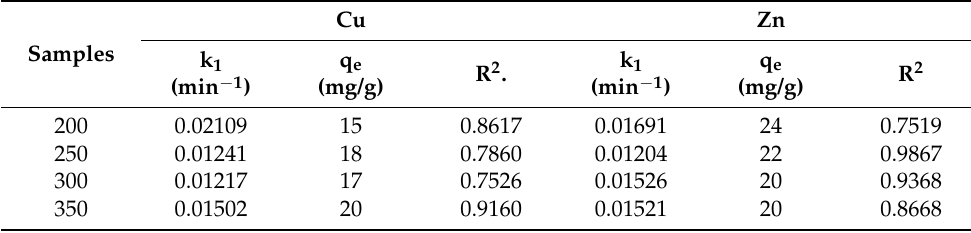
Table 2. Parameters of pseudo − first order model.